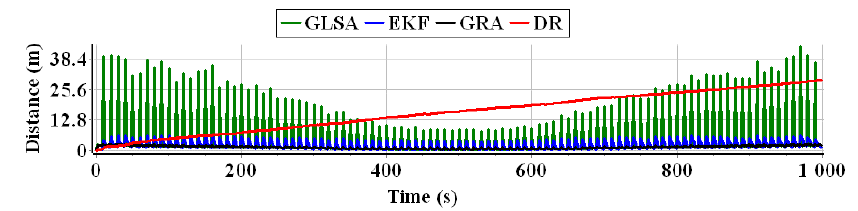
Figure 16. Distance to reference position from estimated position during a single SV crossing as a function of time.